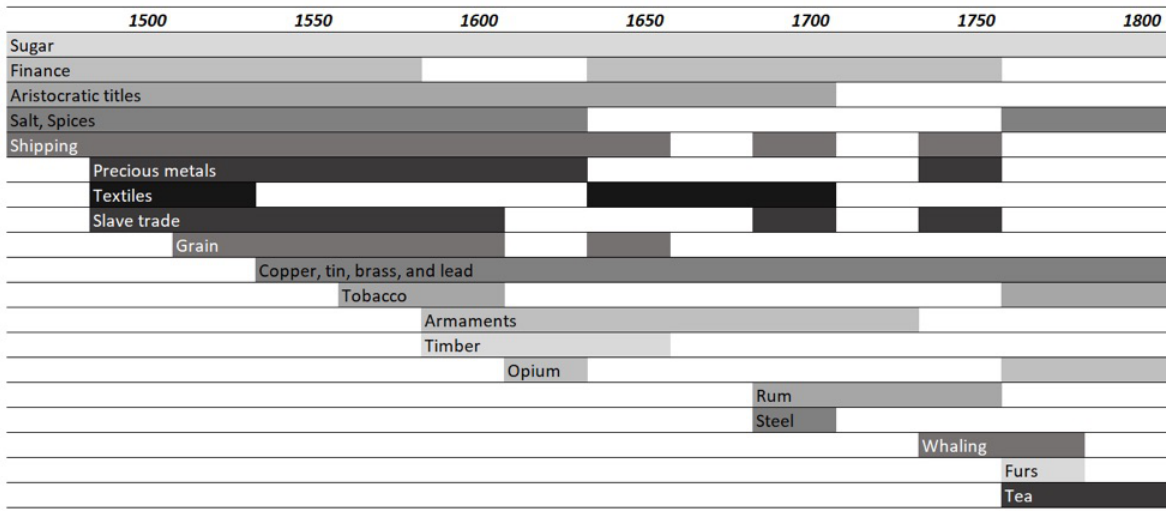
Source: World-Magnates Database (Korzeniewicz and Payne